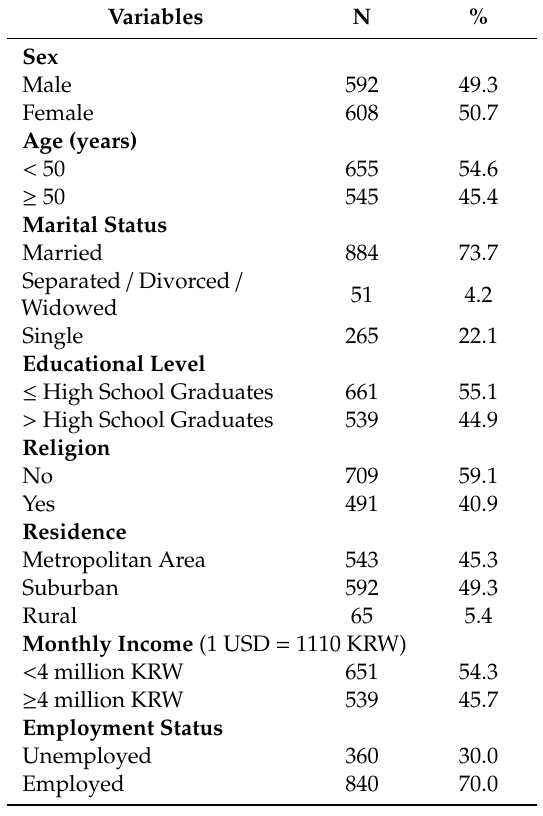
Table 1. Demographics of the Study Participants.